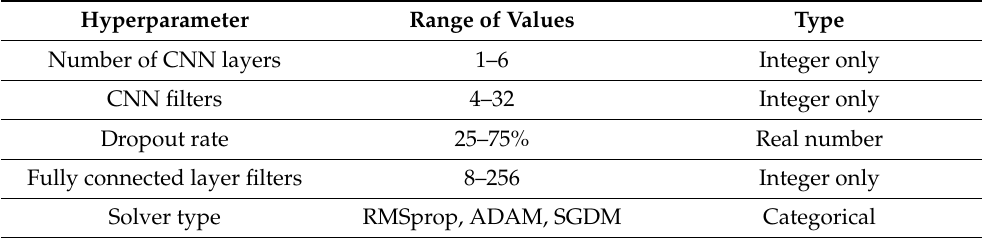
Table 1. Summary of Bayesian-optimized hyperparameters for